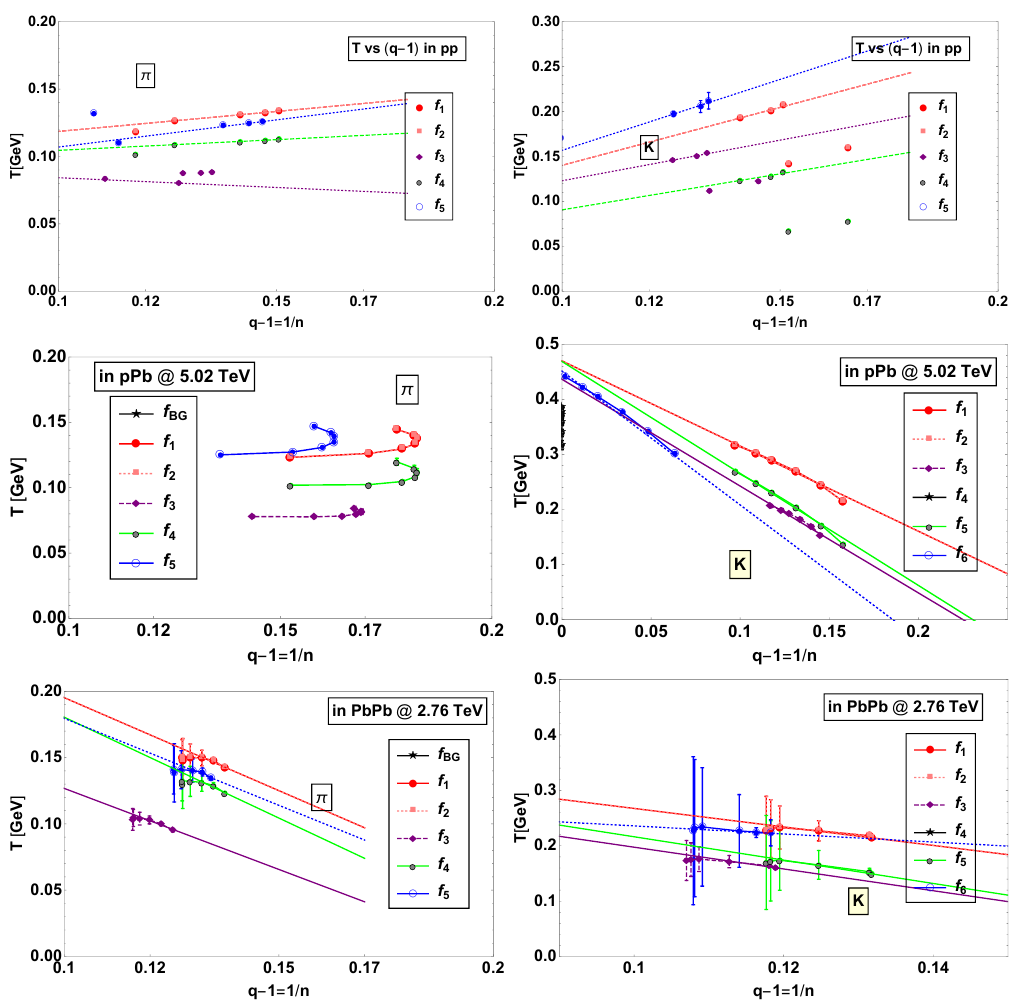
Figure 3. Correlations between T and q − 1 = 1/ n for spectra of π (left) and K (right) in pp , pPb , and PbPb collisions. The corresponding p T range is listed in Table 4, and the values of fitting parameters in Equation (11) are listed in Table